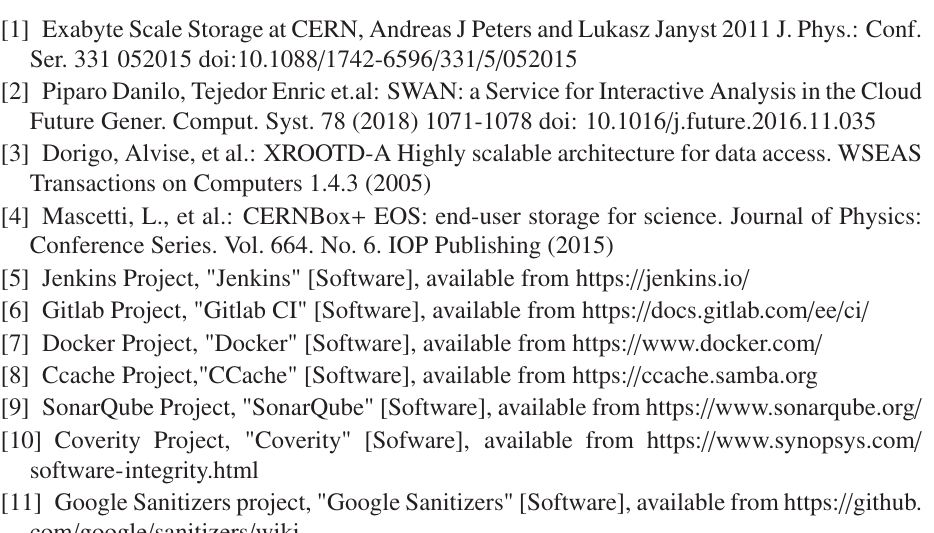
Figure 6. EOS Gitlab CI